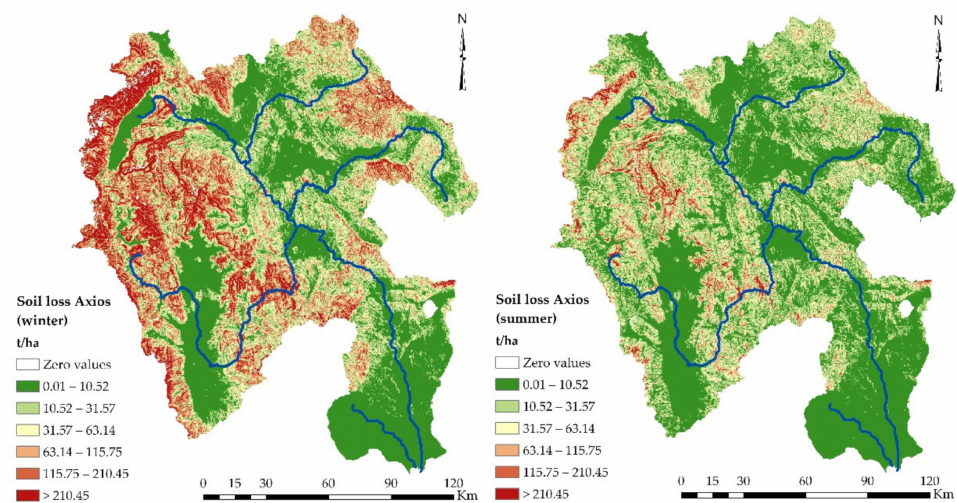
Figure 15. Average seasonal soil loss for the Axios catchment area during winter ( left ) and summer ( right ).